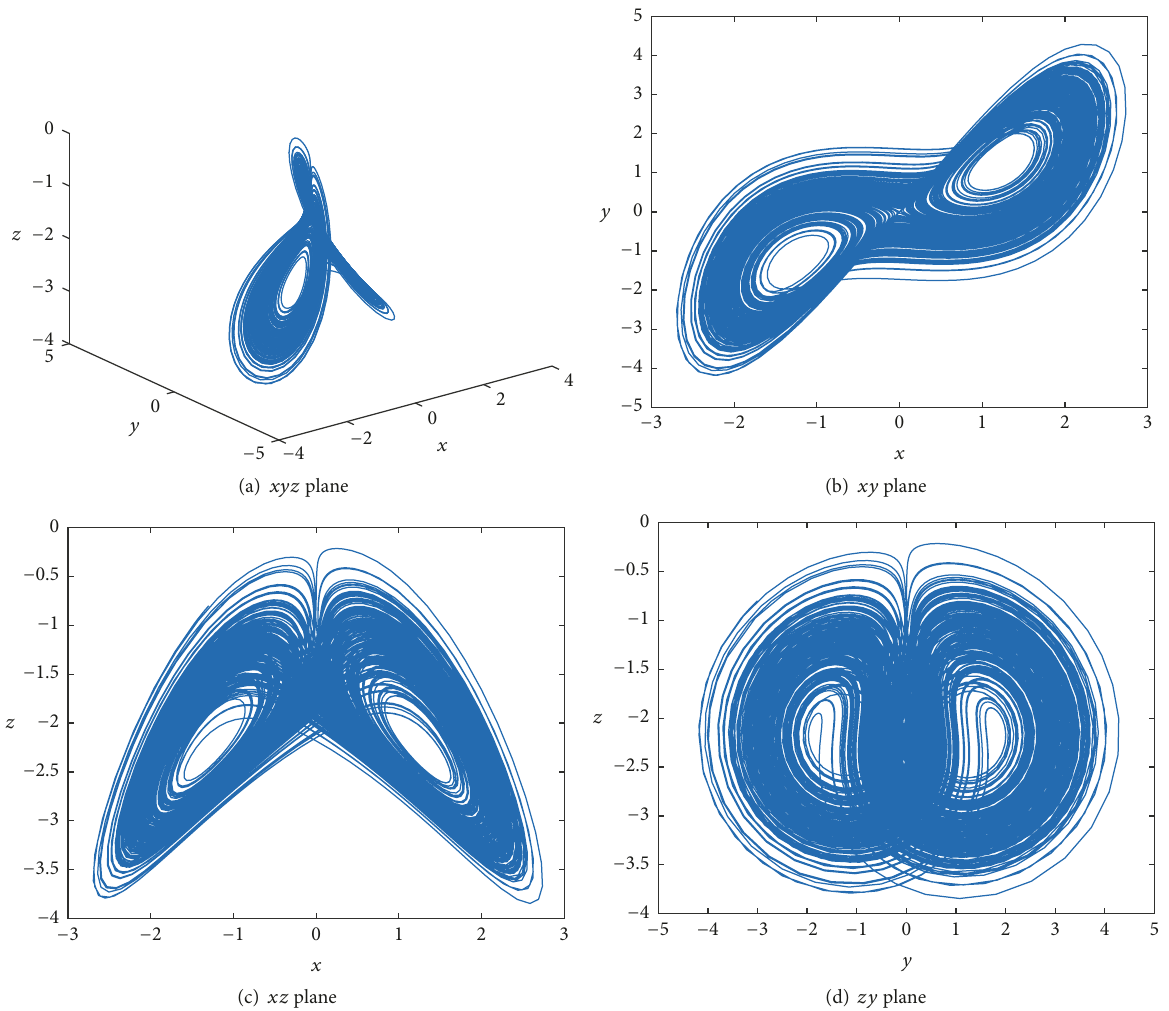
Figure 1: The chaotic attractors of the modified Lorenz-like chaotic